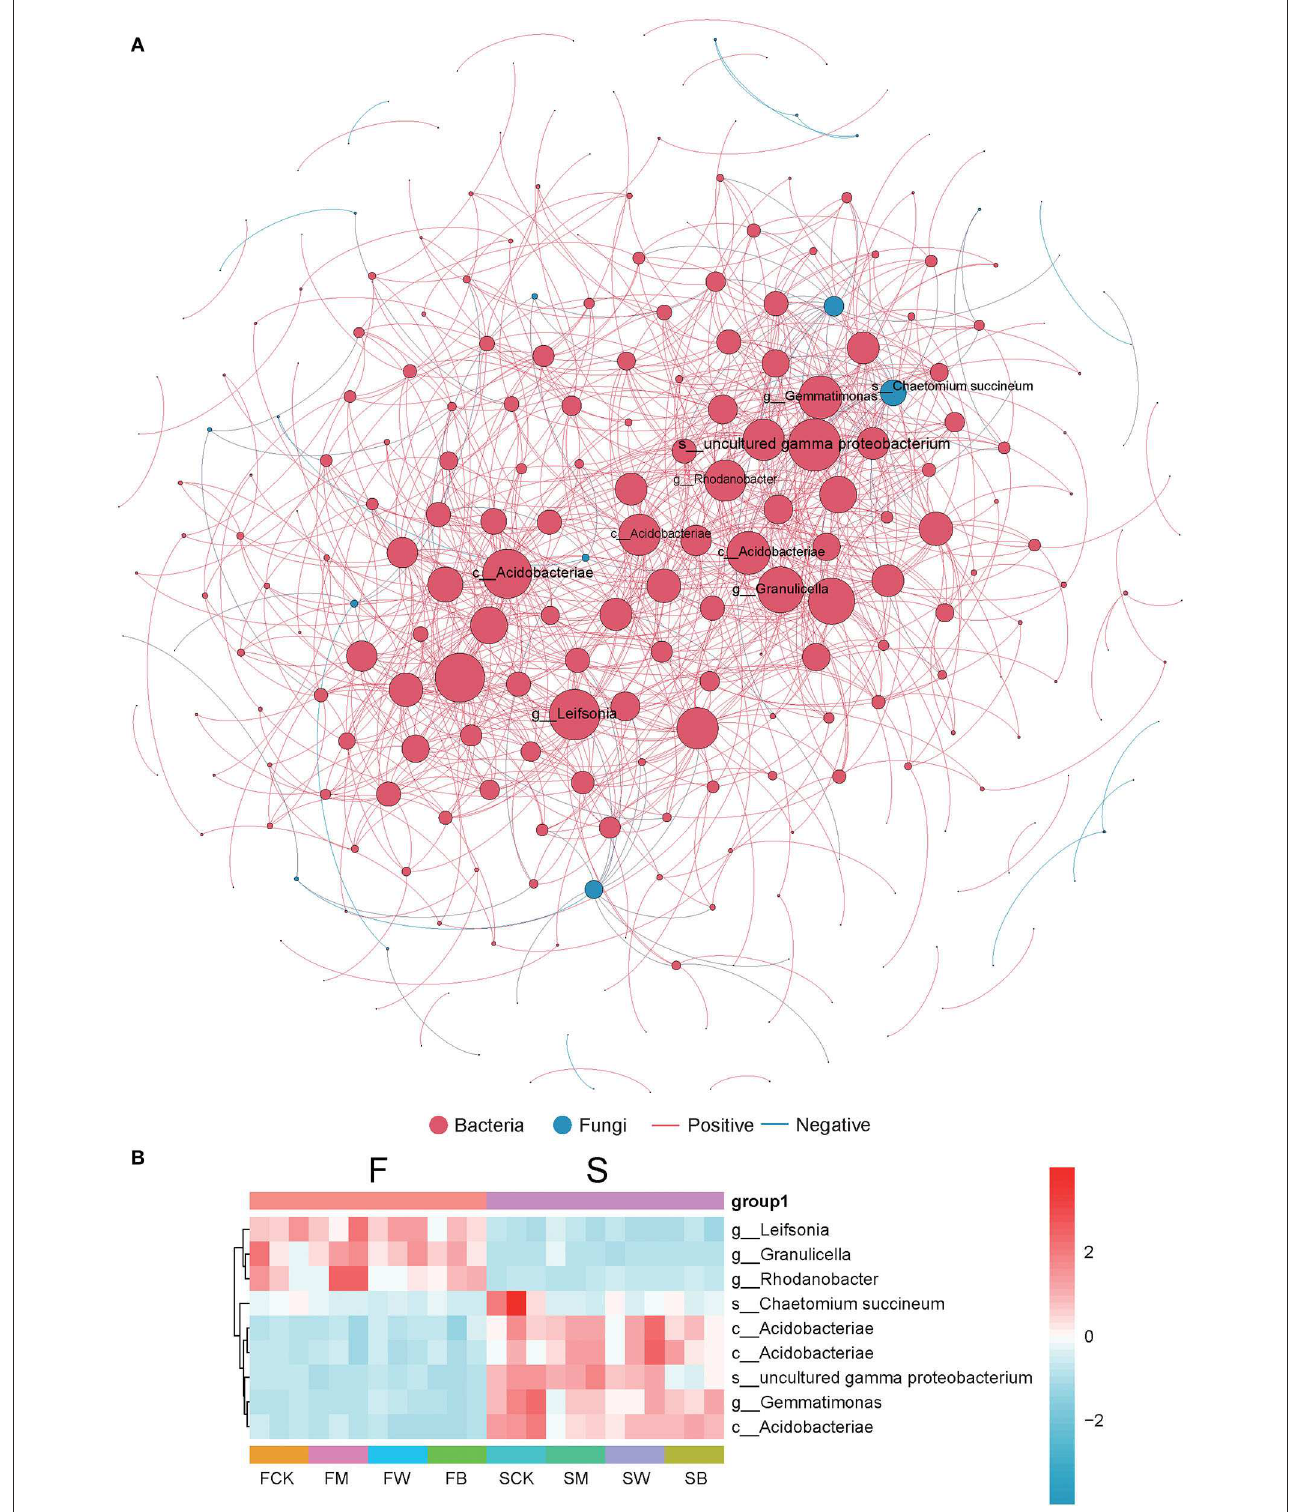
FIGURE7 Co-occurrence network analysis of soil microorganism communities. The size of the node is proportional to the relative abundance of the genus. Each connection shown has a Spearman’s coefficient of > 0.6 and a P < 0.05. The red color indicates bacteria, the green color indicates fungi, the red line shows a positive correlation, and the blue line shows a negative correlation (A) . The heat map of several abundant dominant bacteria in a collinear network (B)